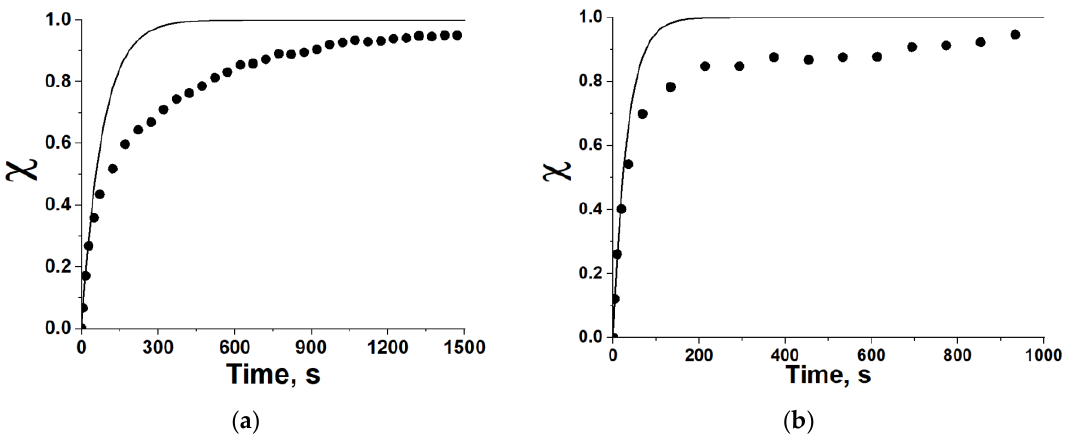
lines—exponential approximation (3).